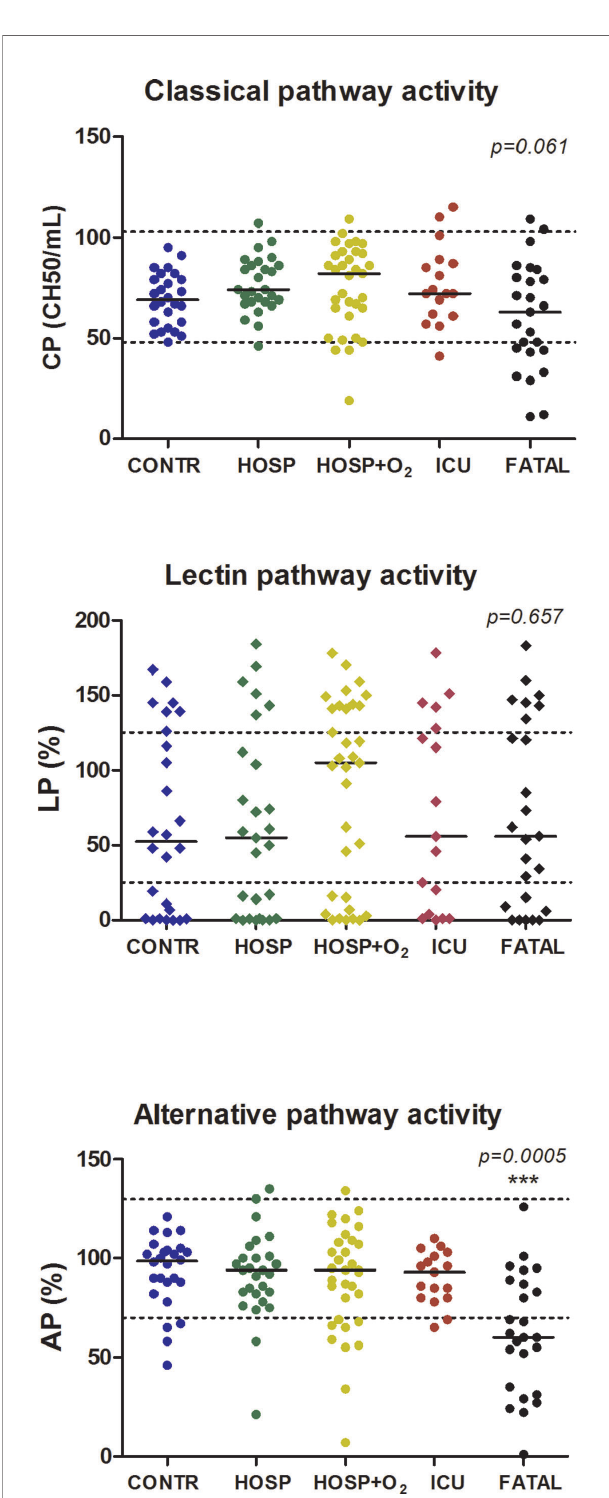
FIGURE 3 | Association between complement functional activity and peak severity of SARS-CoV-2 infection. The horizontal solid lines indicate group median, horizontal dashed lines indicate reference range limits, p-values were obtained by Kruskal-Wallis test; asterisks indicate results of Dunn ’ s post test (***p < 0.001), when compared to